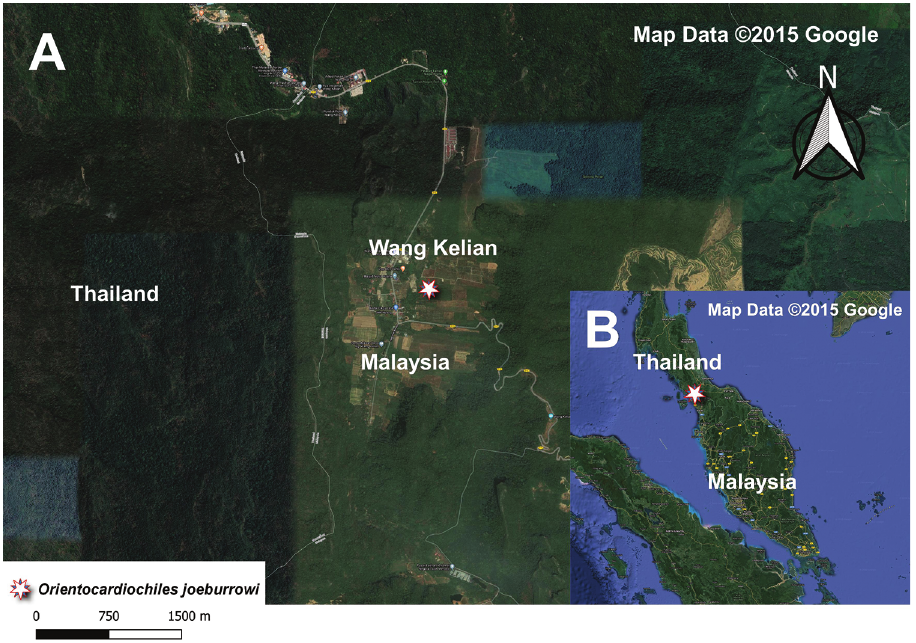
Figure 4. A Distribution map of Orientocardiochiles joeburrowi sp. nov. in Wang Kelian B distribution map of O. joeburrowi sp. nov. in